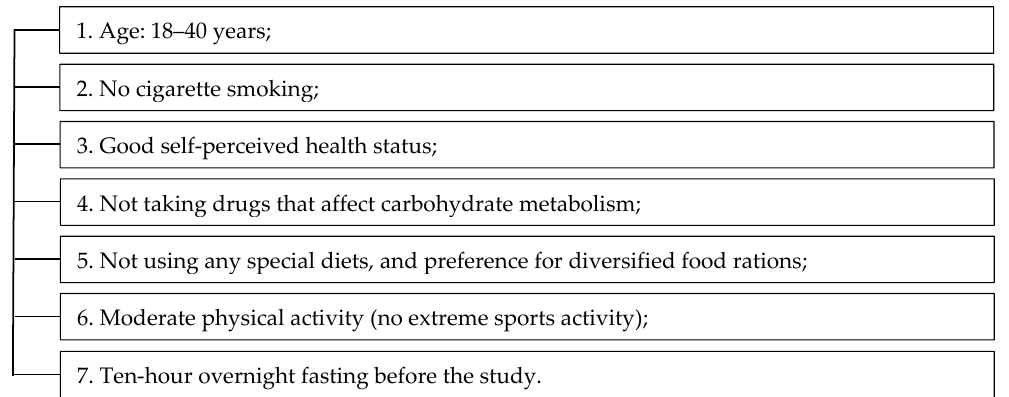
Figure 1. Inclusion criteria for the participation in the study.